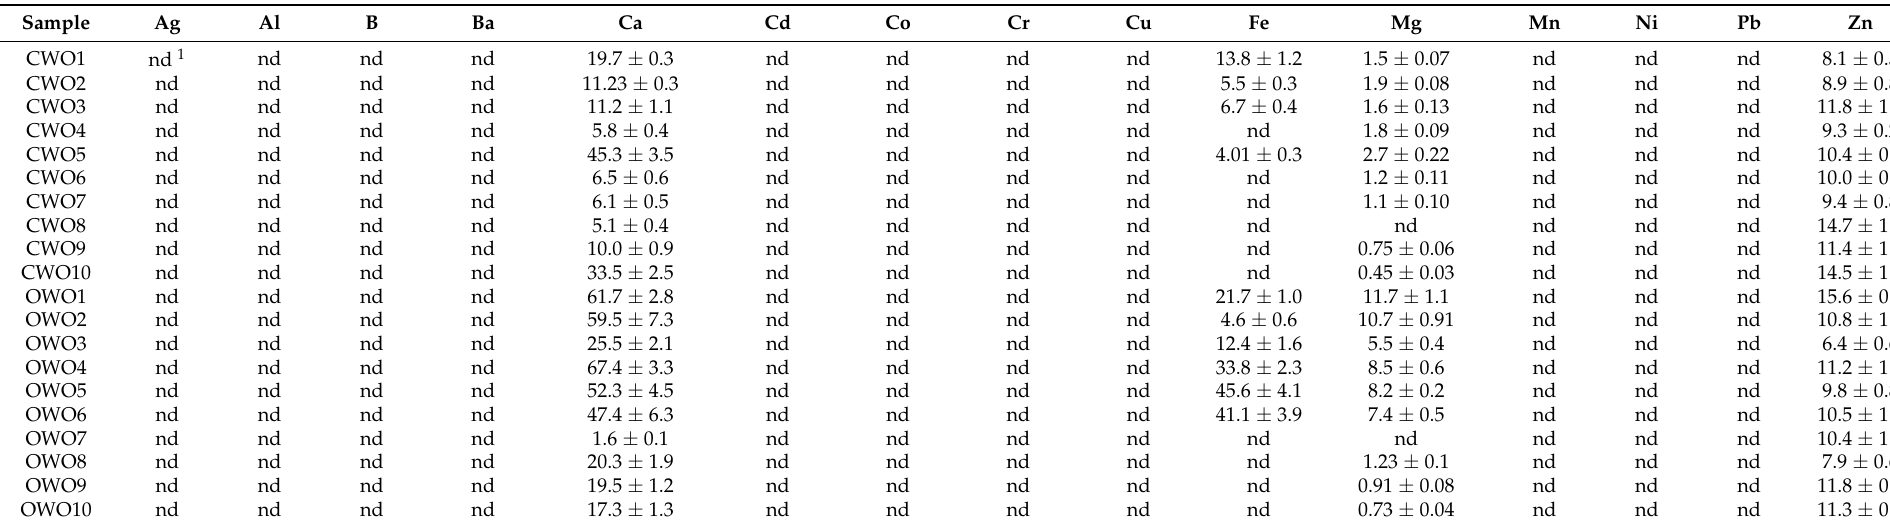
Table 5. Elemental analysis of organic and conventional walnut oils sample (concentrations expressed in µ g g − 1 )